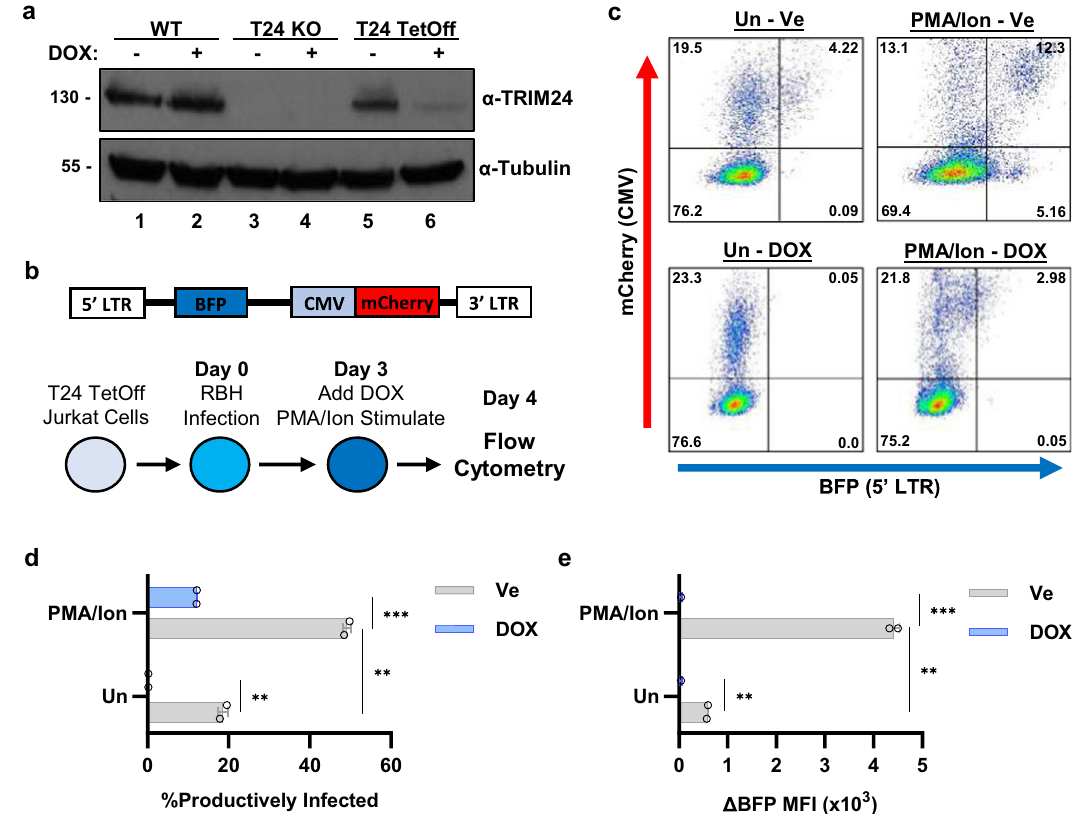
Fig. 5 TRIM24 knockout encourages the establishment of immediate latency. a Wild-type, TRIM24 KO, or TRIM24 TetOff Jurkat cells were untreated or incubated with 1 µ g/mL doxycycline for 20 h, when whole-cell lysates were analyzed by immunoblotting with TRIM24 or Tubulin antibodies. b Schematic depiction of the Red-Blue-HIV-1 reporter virus (RBH) assay. TRIM24 knockout Jurkat cells transduced with a TetOff TRIM24 expression lentivirus were infected with RBH. Three days post infection, cells were untreated or incubated with 1 µ g/mL doxycycline (DOX); 2 h post DOX treatment, cells were treated with a vehicle control (DMSO) or 10 nM PMA/1 µ M ionomycin. Flow cytometry was performed 20 h later to measure infection (red) and HIV-1 (blue) reporter expression. c Representative fl ow cytometric scatterplots of cells treated as described in ( b ); mCherry intensity is displayed on the Y axis, and BFP expression on the X axis. For each scatterplot, the bottom left quadrant indicates uninfected cells (mCherry − /BFP − ), the top left indicates the latent population(mCherry + /BFP − ), the top right indicates productively infected cells (mCherry + /BFP + ), and the bottom right depicts noise generated from viral rearrangements (BFP + ). d Summary of scatterplot data produced from RBH TRIM24 rescue experiments. Shown is the percentage of productively infected cells, with error bars representing standard deviation ( n = 2, mean ± SD). e Same as ( d ), but data are presented as the change in BFP mean fl uorescent intensity (MFI) as compared to RBH uninfected, fl uorescent-negative cells ( n = 2, mean ±